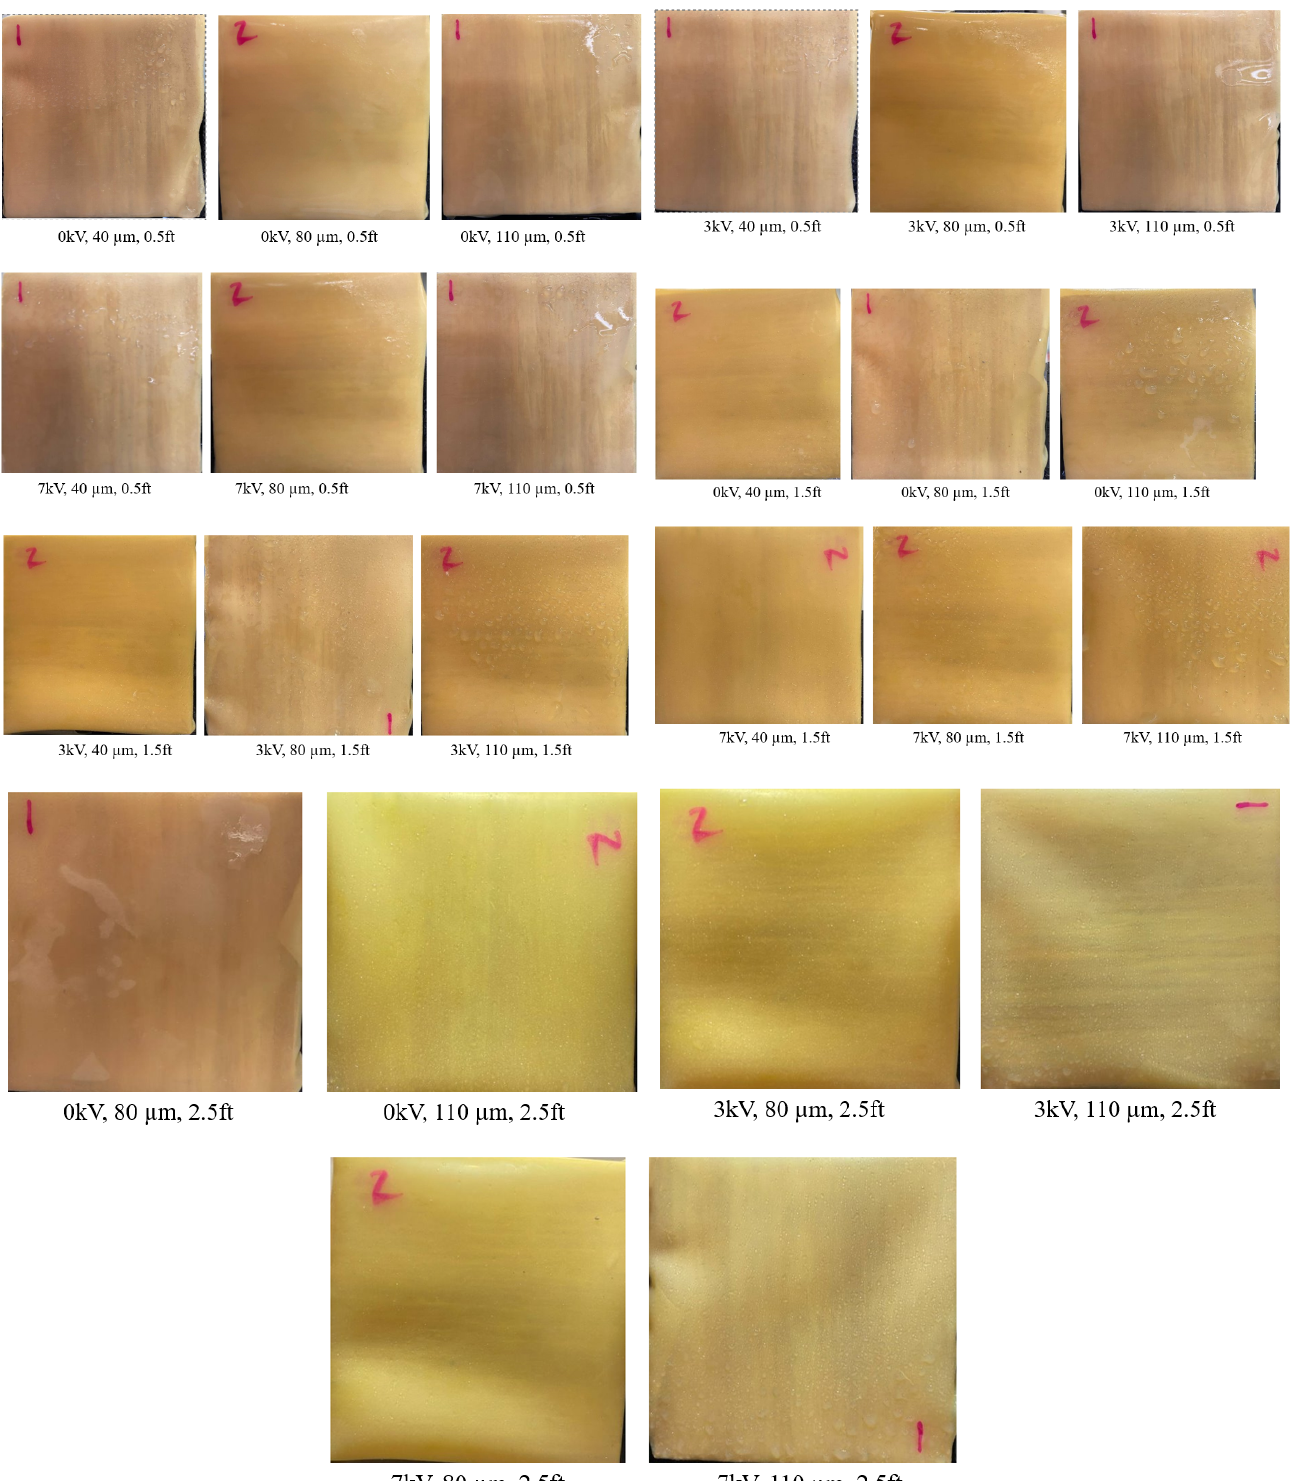
Figure A25. Rubber: qualitative images of electrostatic deposition under various system